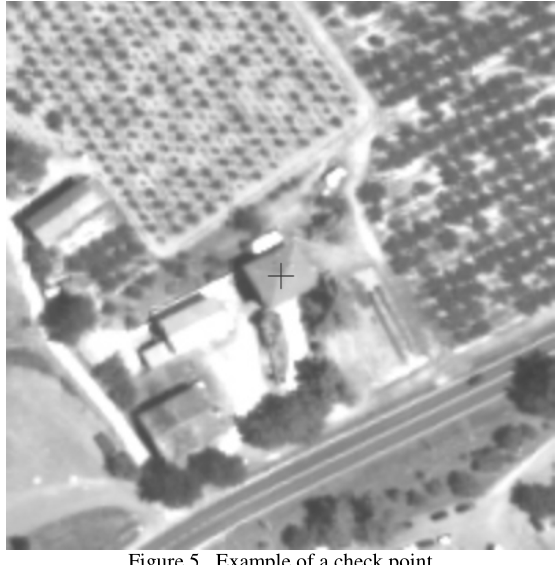
Figure 5. Example of a check